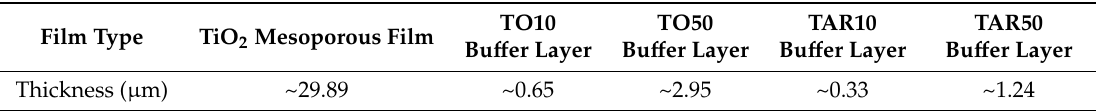
Figure 1. SEM micrographs of samples with the mesoporous TiO 2 deposited directly on fluorine-doped tin oxide (FTO) ( a ) and structures with TiO 2 buffer layers deposited by pulsed laser deposition (PLD) on FTO in oxygen at 10 Pa (TO10) ( b ), and 50 Pa (TO50) ( c ), in argon at 10 Pa (TAR10) ( d ), and at 50 Pa (TAR50) ( e ). Table 1. Thickness of TiO 2 mesoporous coatings and of TiO 2 buffer layers deposited by PLD, on a SnO 2 :F conductive film of 0.41 µm.